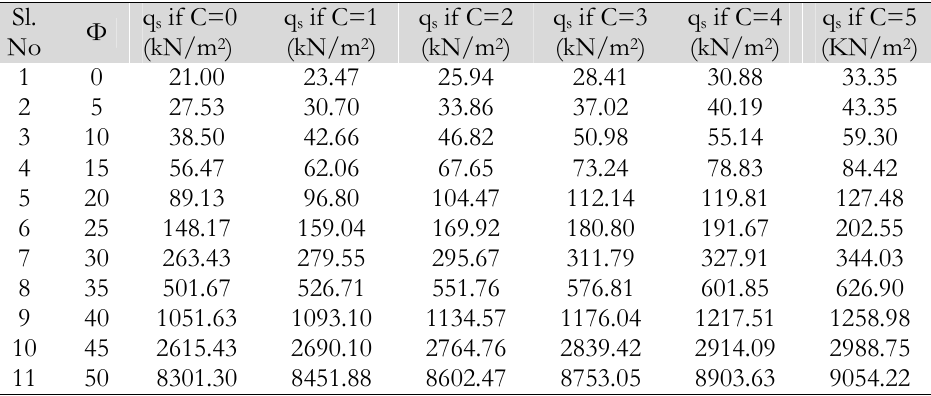
Table 1: Safe bearing capacity of soil when cohesion of soil (C) is varied, soil density is 14 kN/m 3 and width and depth of foundation are equal to 1.5 and 2.5 m,